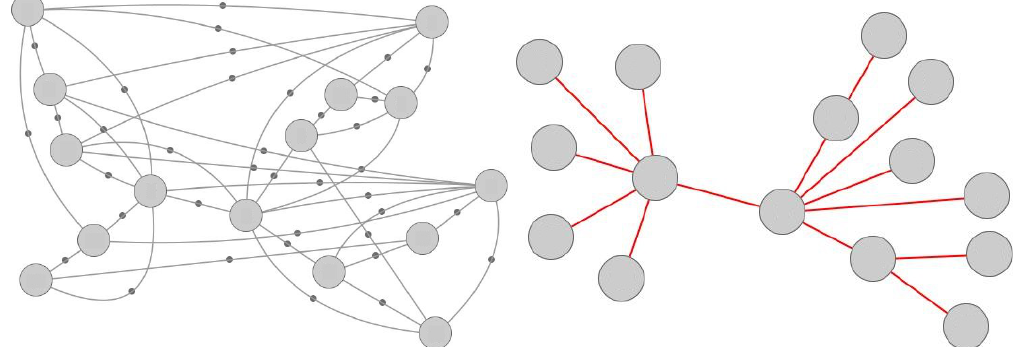
Figure 3: The original graph (on the left) and the resulted spanning tree (on the right)